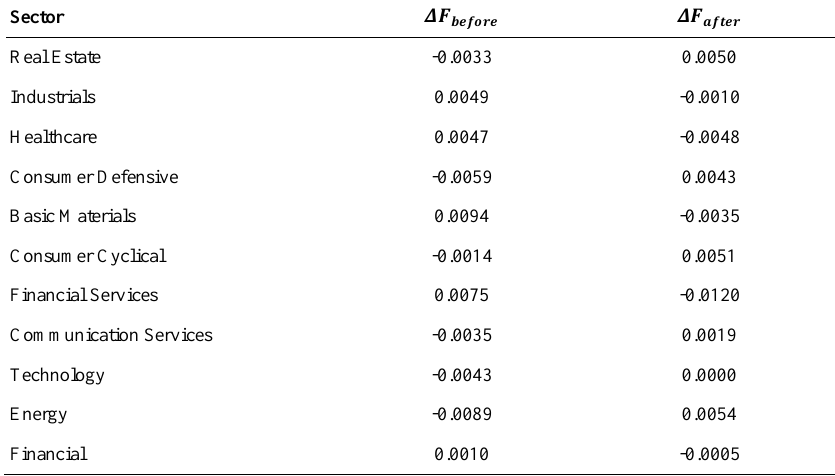
Table 6. The net information outflow for the sectors in JSE market, before and after COVID-19 outbreak